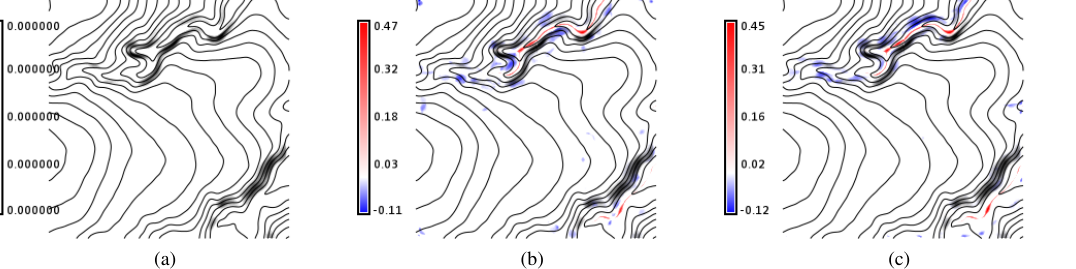
Figure 7: (a) The difference of the reference landscape, (b) the mean of digitally sculpted models, (c) and the mean of tangibly sculpted models from the reference landscape